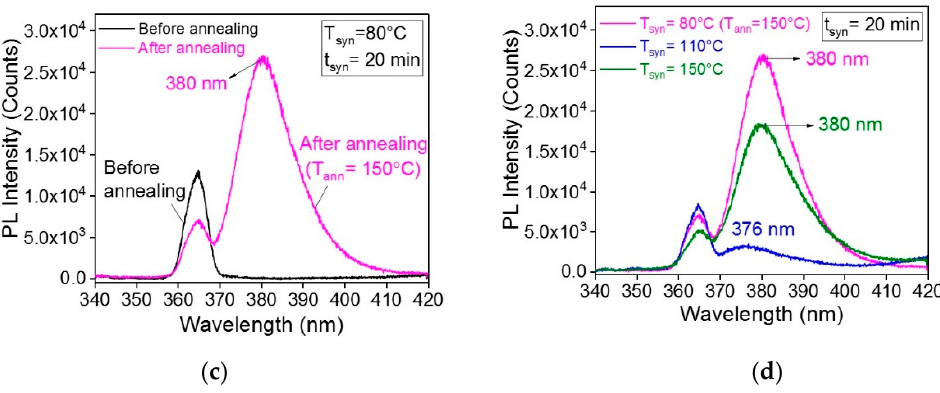
Figure 1. UV zone of the photoluminescence spectra of ZnO nanostructures in raw material solution: ( a ) Effect of the time of the reaction carried on at 80 °C, ( b ) effect of the reaction temperature on the ZnO UV-emission lasting for 20 min, ( c ) effect of annealing at 150 °C on the ZnO synthesis reaction done at 80 °C for 20 min, ( d ) sum-up of the reaction temperature conditions to obtain UV-exciton emission.